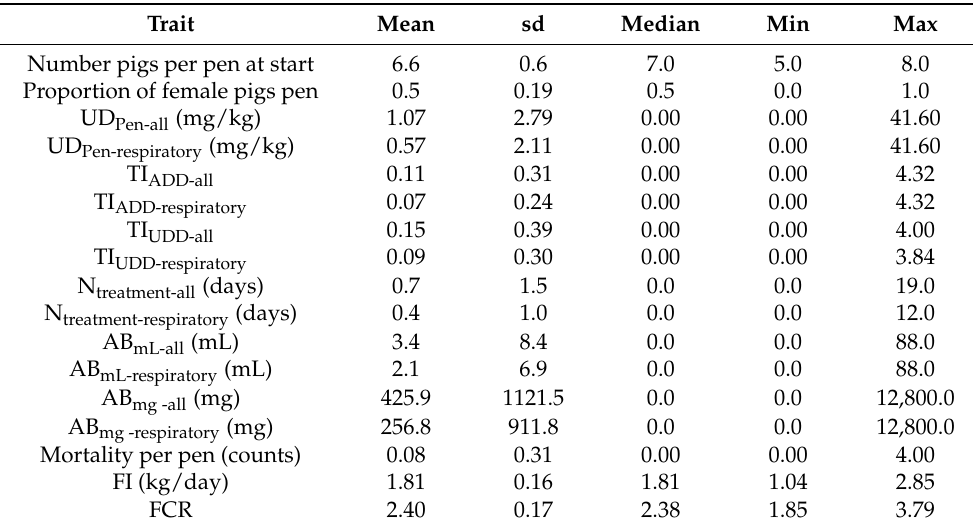
Table 1. Descriptive statistics of traits at pen level for antibiotics usage parameters and other production traits (final data, N = 2238 pens).